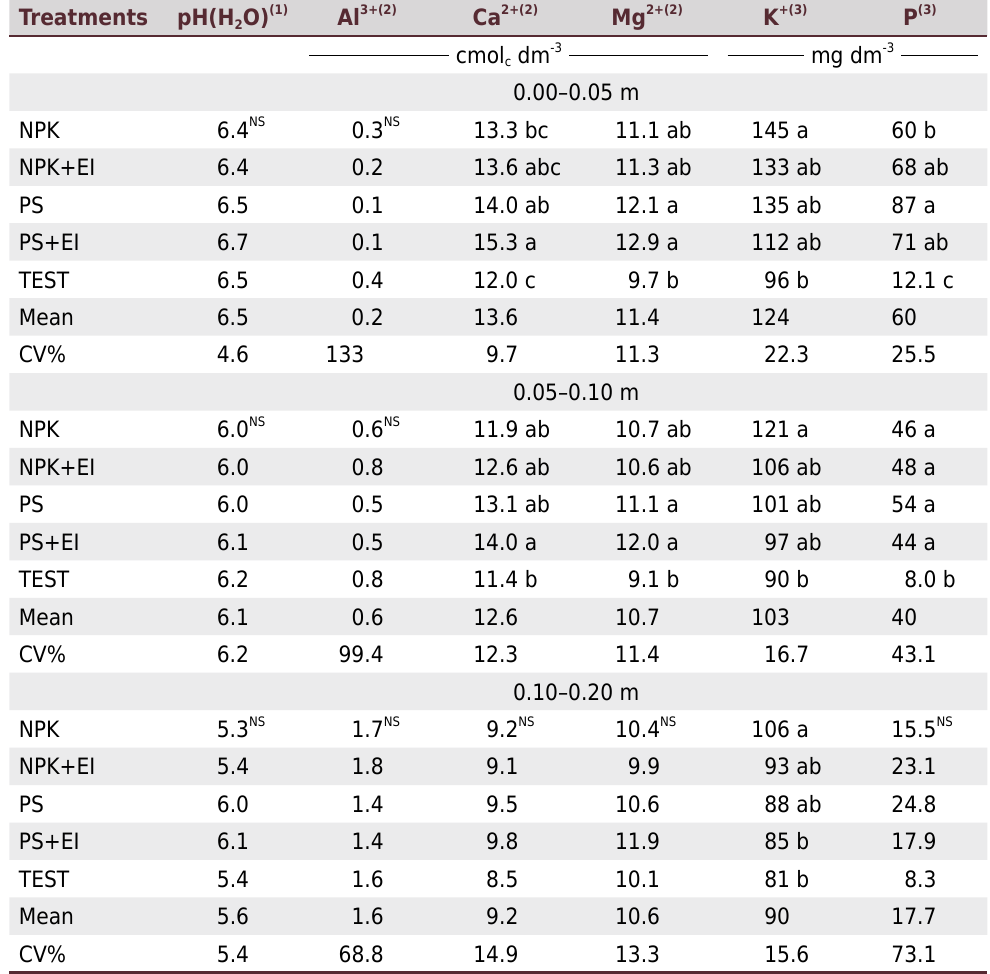
Table 2. Chemical properties in the soil layers 0.00-0.05, 0.05-0.10, and 0.10-0.20 m in a Cambissolo Húmico Álico (Humic Cambisol) after three years of fertilizations with mineral fertilizer (NPK), mineral fertilizer plus enzyme inhibitors (NPK+EI), pig slurry (PS), pig slurry plus enzyme inhibitors (PS+EI), and control without fertilization (TEST). Means of the applications forms on the soil surface and incorporated into the soil and four reps